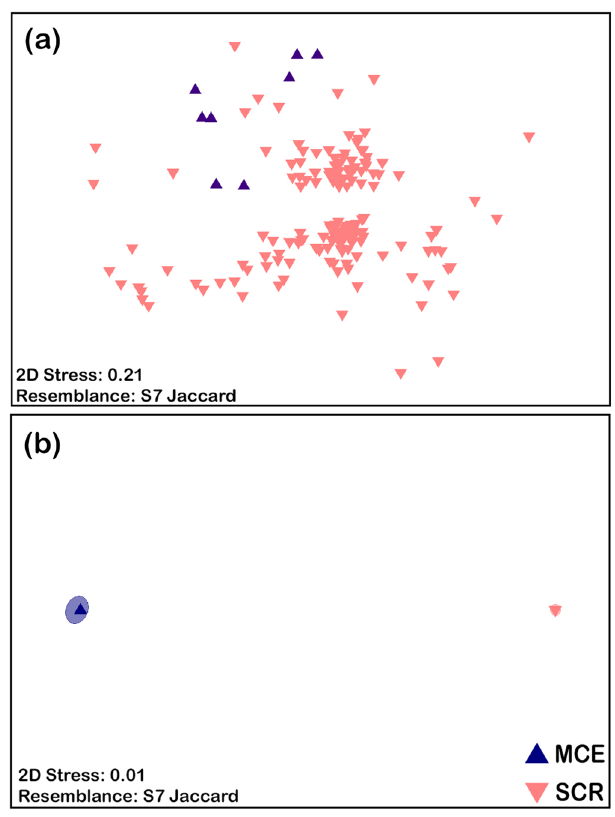
Figure 4. ( a ) NMDS plot for MCE and SCR sites. ( b ) NMDS plot of bootstrap averages for lumped MCE and SCR sites.